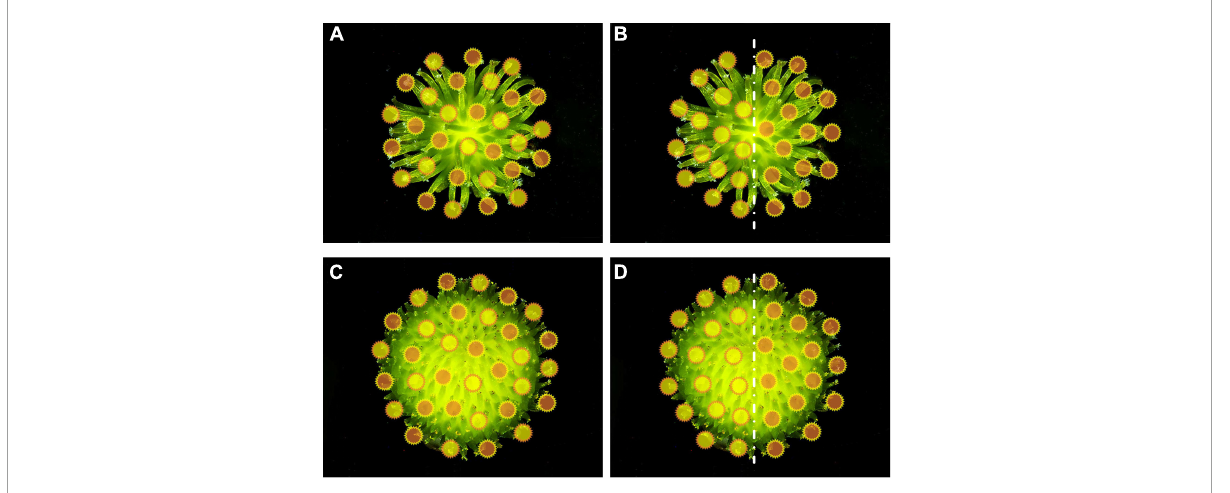
FIGURE1 Diagram of mixed pollination (A,C) and half-and-half pollination (B,D) pollen distribution with Sagittaria pygmaea (A,B) and S. trifolia (C,D) as maternal parent, respectively. The orange circles represent S. pygmaea pollen and yellow circles represent S. trifolia pollen, but do not represent the actual pollen